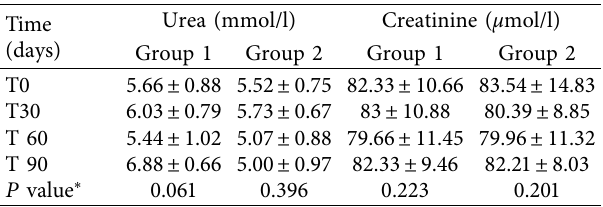
∗ P value; difference between T0 and T90 for each group and each